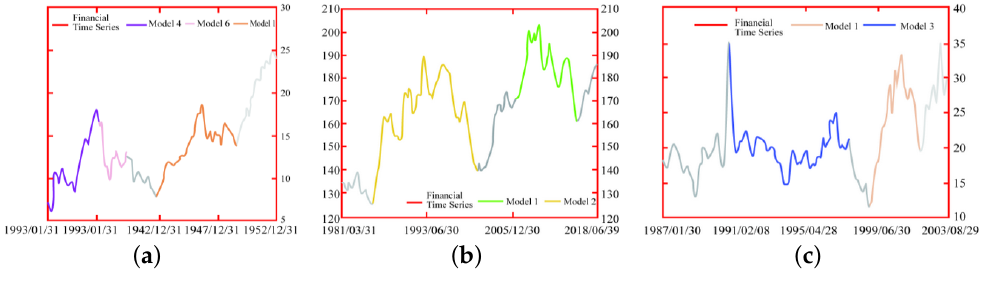
Figure 10. Example of prediction results of the DL-EWP model.